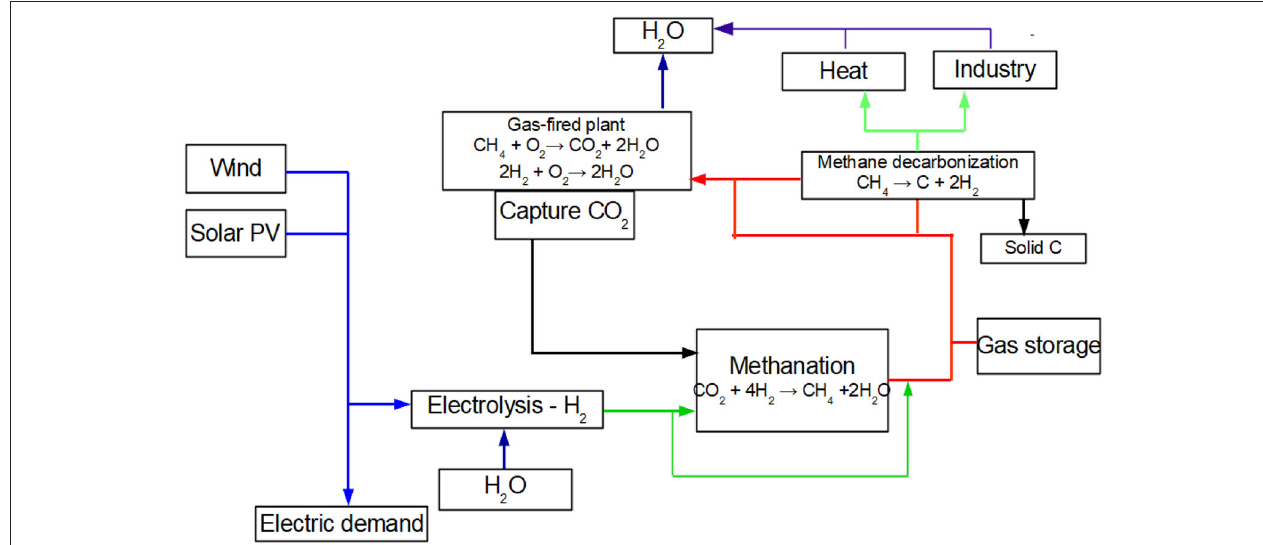
FIGURE 1 | Methane decarbonization into the Power-to-Gas